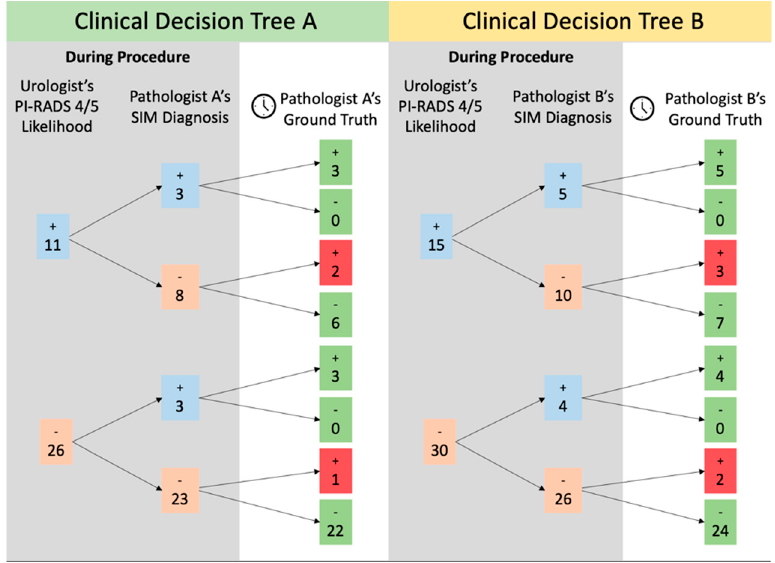
Figure 5. Decision tree of urologist’s interpretation of the likelihood of clinically significant cancer accuracy and subsequent SIM diagnosis accuracy. Both levels are compared to the pathologists’ “gold-standard” diagnoses from histology slides. The blue values represent the number malignant predictions or diagnoses, and pink values represent the number of nonmalignant predictions or diagnoses. Green numbers indicate correct diagnoses from the pathologist and red numbers indicate incorrect diagnoses from the pathologist.